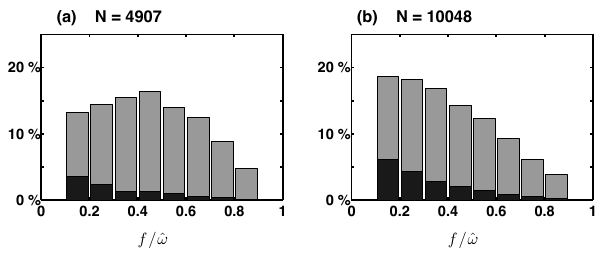
Figure 5. Histogram of the parameter f/ ˆ ω for summer (a) and win- ter (b) season. Grey and black parts of the histogram represent the upward and downward energy propagating IGWs